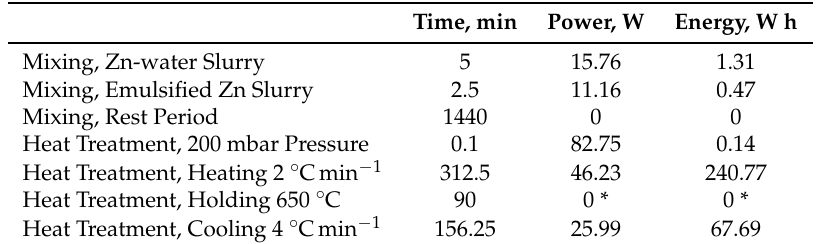
Table 1. Calculated thermal sintering time, power, and energy consumption for preparation of 1 kg Zn electrodes, according to the process described in Ref.